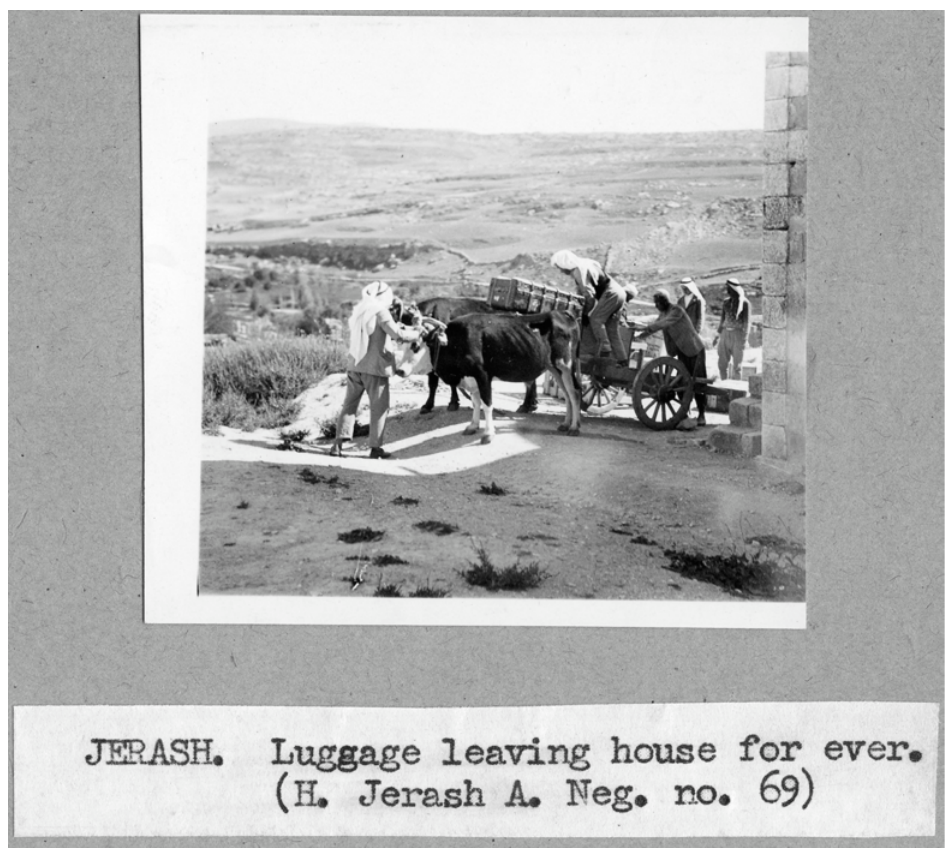
Fig. 10: This poignant label on a photograph in the Horsfield archive records the Horsfields’ departure from Jerash for the last time in 1936. (Copyright UCL Institute of